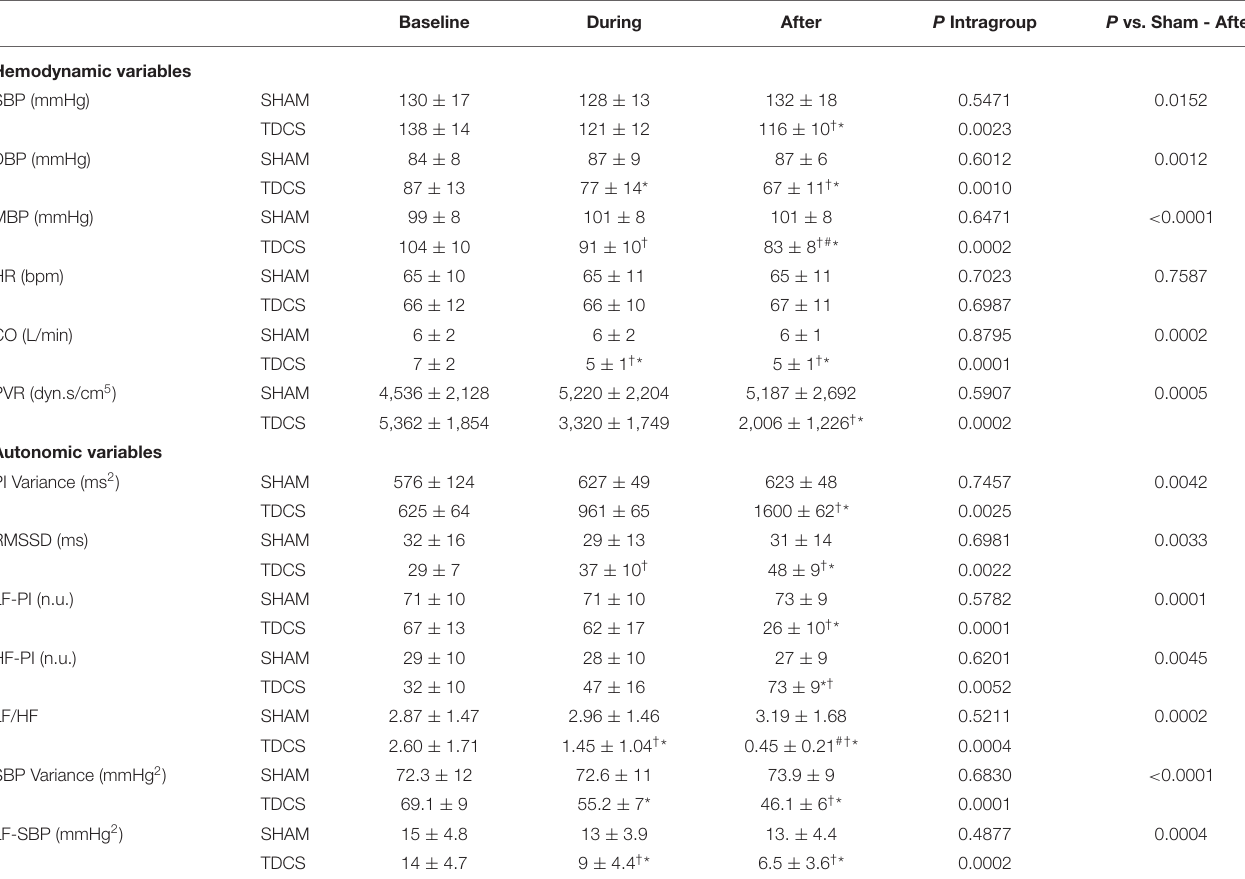
TABLE 2 | Acute intervention: hemodynamic assessments of resistant hypertensive patients at baseline, during, and after tDCS or SHAM conditions. Baseline During After P Intragroup P vs. Sham - After Hemodynamic